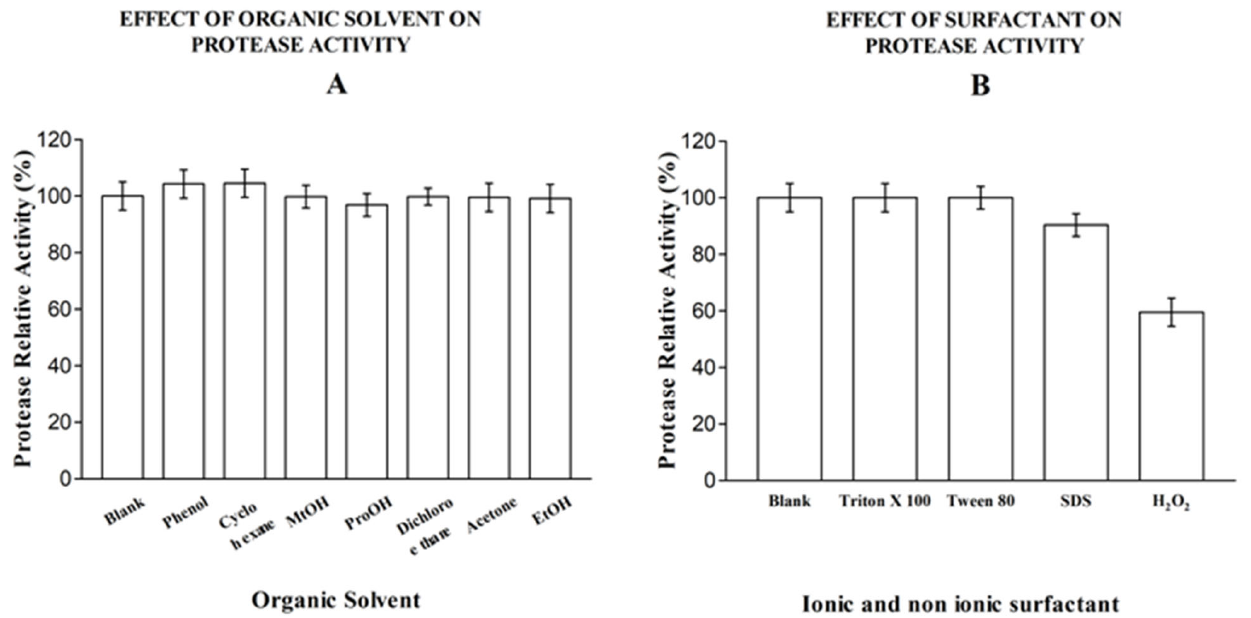
Figure 7. Characterization of semi-purified enzyme extracted from compost soil isolate Bacillus subtilis D3L/1: Bar represents relative activity of protease (%); ( A ) effect of organic solvents on protease activity; ( B ) effect of ionic and non-ionic surfactants, inhibitors, and oxidizing agents on enzyme activity. The statistical significance was p < 0.05.